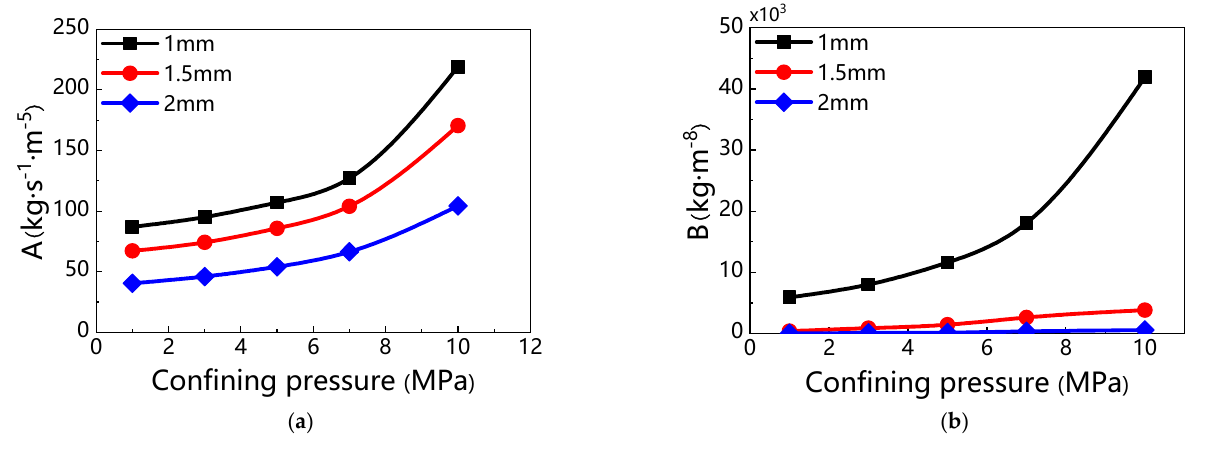
Figure 17. ( a ) Relationship between the linear coefficient A and confining pressure; ( b ) relationship between the nonlinear coefficient B and confining pressure.